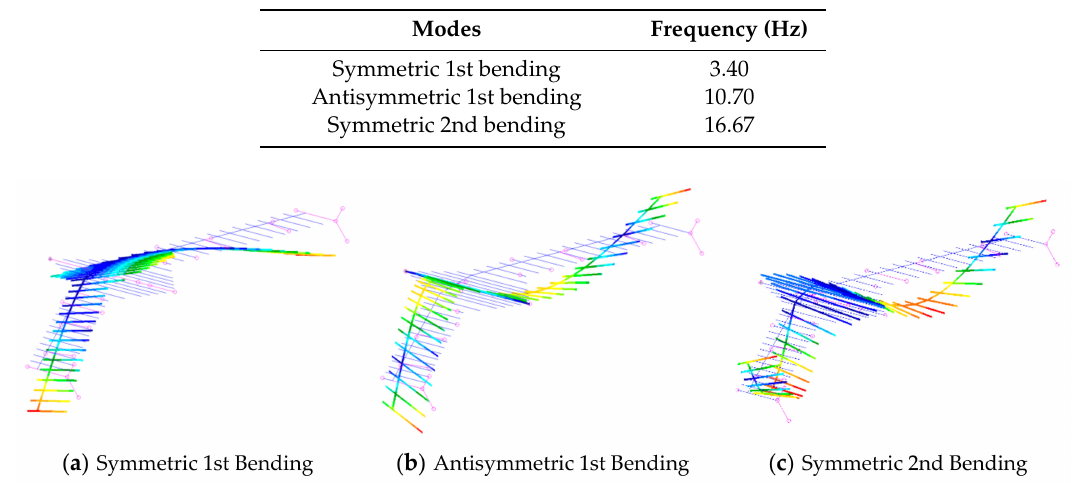
Figure 5. First three elastic modal shapes of BFF wind tunnel test UAV.